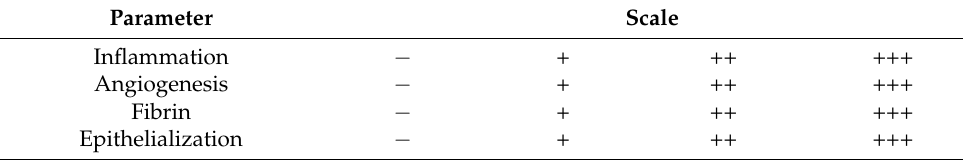
Table 4. Parameters for microscopy analysis [31].